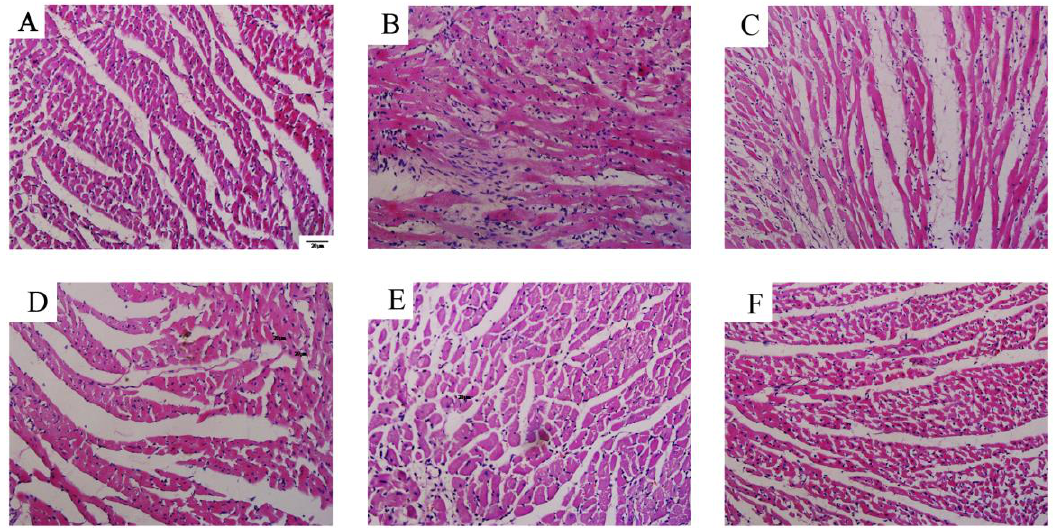
Figure 4. ( A – F ) Effects of betaine on myocardial cells assessed by HE staining (magnification × 200). ( A ) Control group, ( B ) MCT group, ( C ) sildenafil group, ( D ) betaine 100 mg/kg group, ( E ) betaine 200 mg/kg group, and ( F ) betaine 400 mg/kg group.